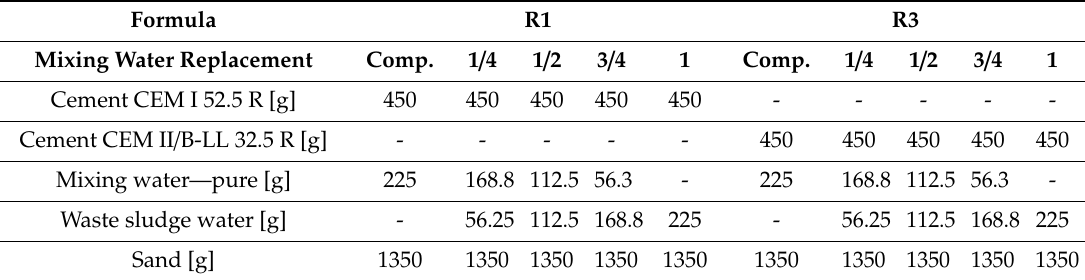
Table 2. Composition of designed